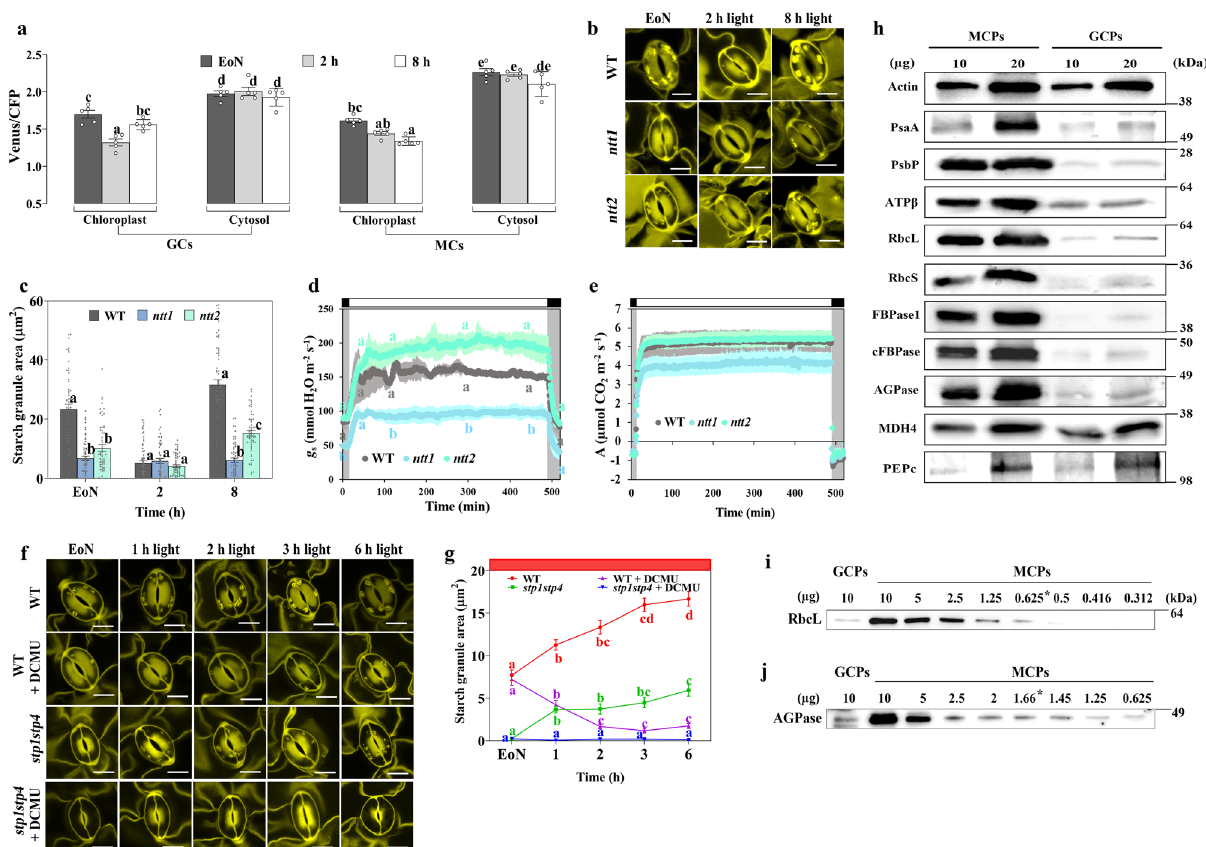
Fig. 5 NTT is important for GC starch synthesis and stomatal opening. a Basal MgATP 2 – Venus/CFP ratio in cytosolic and plastid stroma of guard cells (GCs) and mesophyll cells (MCs) of leaves of 20- to 22-day-old plants collected at the end of night (EoN; 0 h) or after 2 h or 8 h of white light illumination. Different letters indicate signi fi cant statistical differences analysed by one-way ANOVA and Tukey ’ s HSD test ( P < 0.05; n = 5; mean ± SEM). Exact p - values for panel a experiments are provided in the source data fi le. b , c GC starch content of wild-type, ntt1 , and ntt2 plants. Representative confocal laser microscopy images of propidium iodide-stained GC starch granules. Scale bars, 10 µ m. Starch granule area is given in µ m 2 . Each GC starch value represents the mean ± SEM of fi ve biological replicates of more than 30 individual GC pairs for each group. Different letters indicate statistically signi fi cant differences among time points for the given genotype for P < 0.05 determined by one-way ANOVA with post hoc Tukey ’ s test; p -values of panel c at EoN: WT vs. ntt1 = 5.1 × 10 − 9 , and WT vs. ntt2 = 5.1 × 10 − 9 ; at 8 h: WT vs. ntt1 = 5.1 × 10 − 9 , WT vs. ntt2 = 5.1 × 10 − 9 , and ntt1 vs. ntt2 = 8.0 × 10 − 7 . d Whole-plant recordings of changes in stomatal conductance ( g s ) of wild-type, ntt1 and ntt2 plants in response to a shift from dark to light and from light to dark after 8 h of illumination at 150 µ mol m − 2 s − 1 (one-way ANOVA with Tukey ’ s HSD test at P < 0.05; n = 3 per genotype; mean ± SEM; p -values of panel d at 5 min: WT vs. ntt1 = 0.046, ntt1 vs. ntt2 = 0.023; at 120 min: WT vs. ntt1 = 0.018, and ntt1 vs. ntt2 = 0.003; at 300 min: WT vs. ntt1 = 0.023, and ntt1 vs. ntt2 = 0.002; at 450 min: WT vs. ntt1 = 0.041, and ntt1 vs. ntt2 = 0.004). Letters indicate signi fi cant statistical differences between genotypes for the given time points. e Whole-plant recordings of changes in CO 2 assimilation (A ) of wild-type, ntt1 , and ntt2 plants in response to a shift from dark to light and from light to dark after 8 h of illumination at 150 µ mol m − 2 s − 1 . f , g Starch contents of isolated GCs of wild-type and stp1stp4 plants illuminated for 1 h, 2 h, 3 h and 6 h with 300 µ mol m − 2 s − 1 red light (RL) in the presence or absence of 10 µ M 3-(3,4-dichlorophenyl)-1,1-dimethylurea (DCMU) starting at the end of the night (EoN). The isolated GCs were dark-adapted for 1 h before illumination and inhibitor treatment. Each value represents mean ± SEM of four biological replicates of more than 110 individual GCs obtained from three (control) and two (DCMU treatment) independent experiments. Different letters indicate statistically signi fi cant differences among time points for the given genotype for P < 0.05 determined by one-way ANOVA with post hoc Tukey ’ s test. Scale bars, 10 µ m. Exact p -values for panel g experiments are provided in the source data fi le. h Immunoblot analysis of proteins extracted from guard cell protoplasts (GCPs) and mesophyll cell protoplasts (MCPs) using antibodies speci fi c for actin, PSI-A core protein of photosystem I (PsaA), 23 kDa protein of the oxygen-evolving complex of PSII (PsbP), beta subunit of ATP synthase (ATP β ), RubisCO large subunit (RbcL), RubisCO small subunit (RbcS), chloroplastic fructose-1,6-bisphosphatase 1 (FBPase1), cytosolic fructose-1,6-bisphosphatase (cFBPase), ADP-glucose pyrophosphorylase (AGPase), malate dehydrogenase 4 (MDH4) and phospho enol pyruvate carboxylase (PEPc). i , j Titration of the relative amounts of RbcL and AGPase in GCPs by serial dilution of MCP total proteins, using anti-RBcL and anti-AGPase antibodies. This experiment was repeated two times independently. Relative quanti fi cation of the bands was performed with the UVITEC Alliance software. Asterisks (*) indicate equivalent protein band intensities between MCPs and GCPs. Source data are provided as a source data fi and the GC starch turnover pro fi les (Fig. 5b, c), showing that NTT1 is the major isoform of NTTs in GCs.